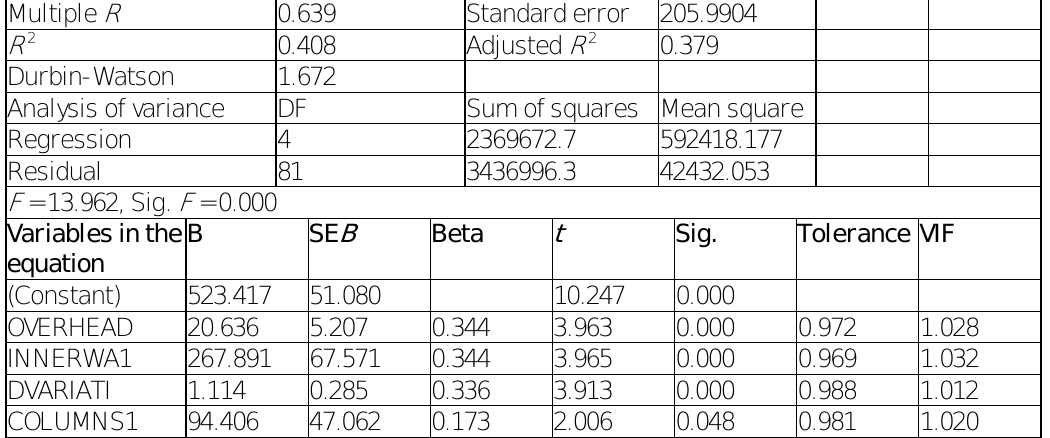
Table 3: Regression analysis results of unit price in PPPs Multiple